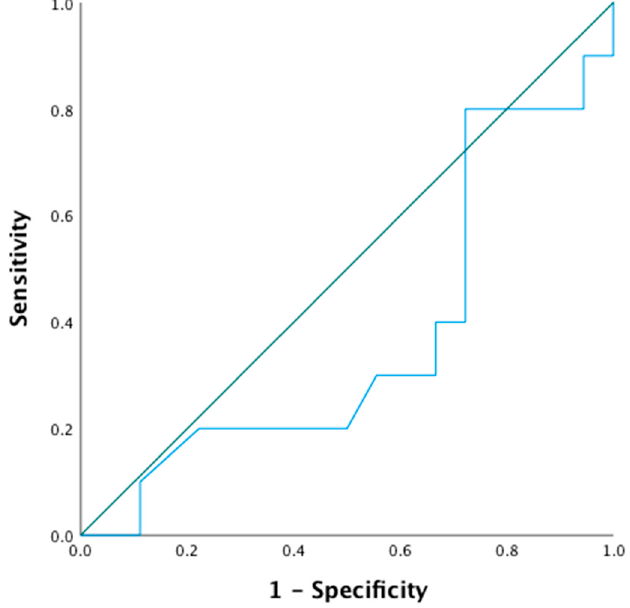
Figure 3. ROC curve of difference in the L/R ratio between the early and late scans, indicating poor discriminative ability.